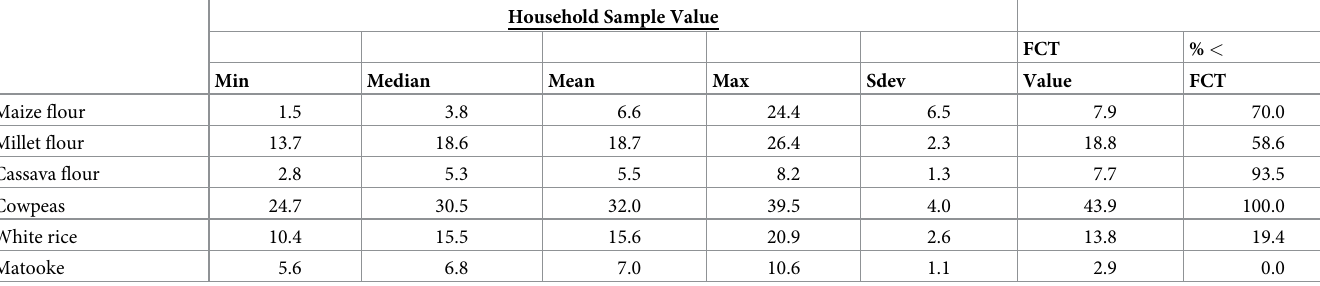
Stars denote significant differences compared to FCT values using a t-test for mean values and a Wilcoxon test for median values ( ��� p < 0.01, �� p < 0.05, � p < 0.1). Source for FCT values: HarvestPlus 1041 from USDA-21 20522 (maize flour), HarvestPlus 1104 from USDA-21 20031 (millet flour), HarvestPlus 2020 from WFDA 10120 (cassava flour, Indonesia), HarvestPlus 6211 from USDA-21 11191 (cowpeas), HarvestPlus 1201 from USDA-21 20450 (white rice), and HarvestPlus 5001 from USDA-21 9277